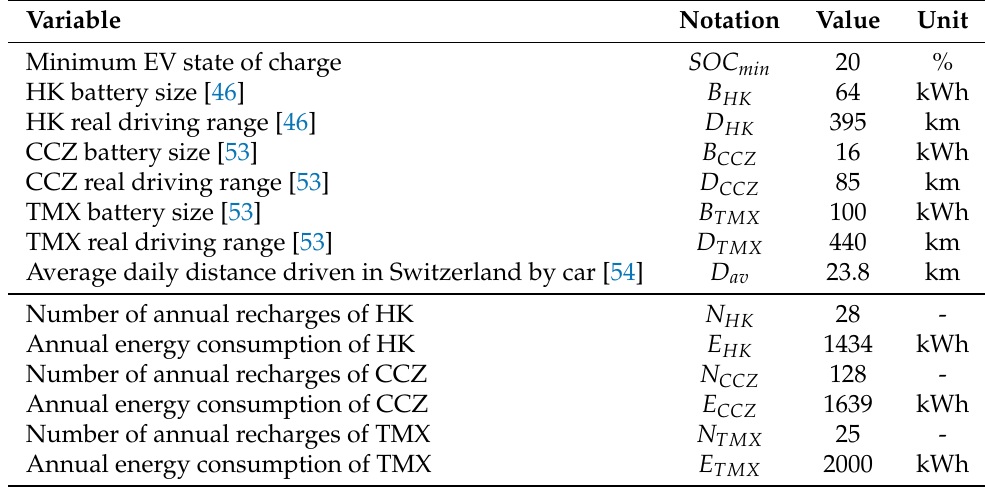
Table 5. Case study data.